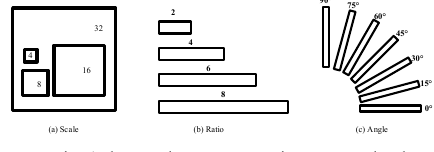
Fig.4 the anchor strategy in our method